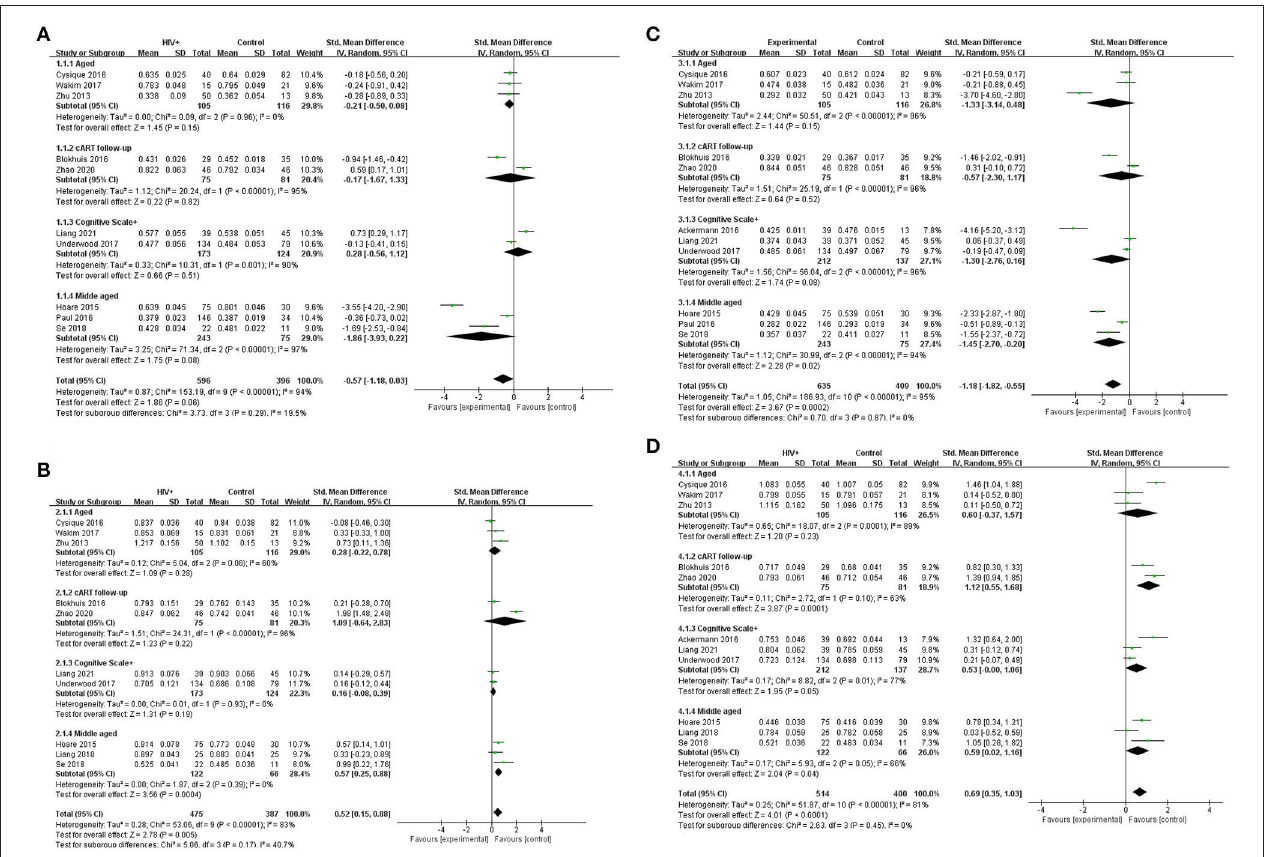
FIGURE 2 | Meta-analysis results of FA and MD between the HIV-positive group and the control group. (A) FA in CC. (B) MD in CC (*10 3 ). (C) FA among other WMF. (D) MD among other WMF (*10 3 ).